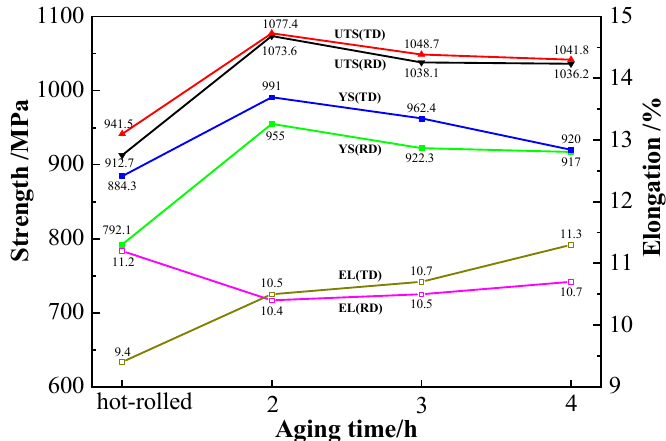
Figure 8. The mechanical properties of TC4 alloy aged sheets.